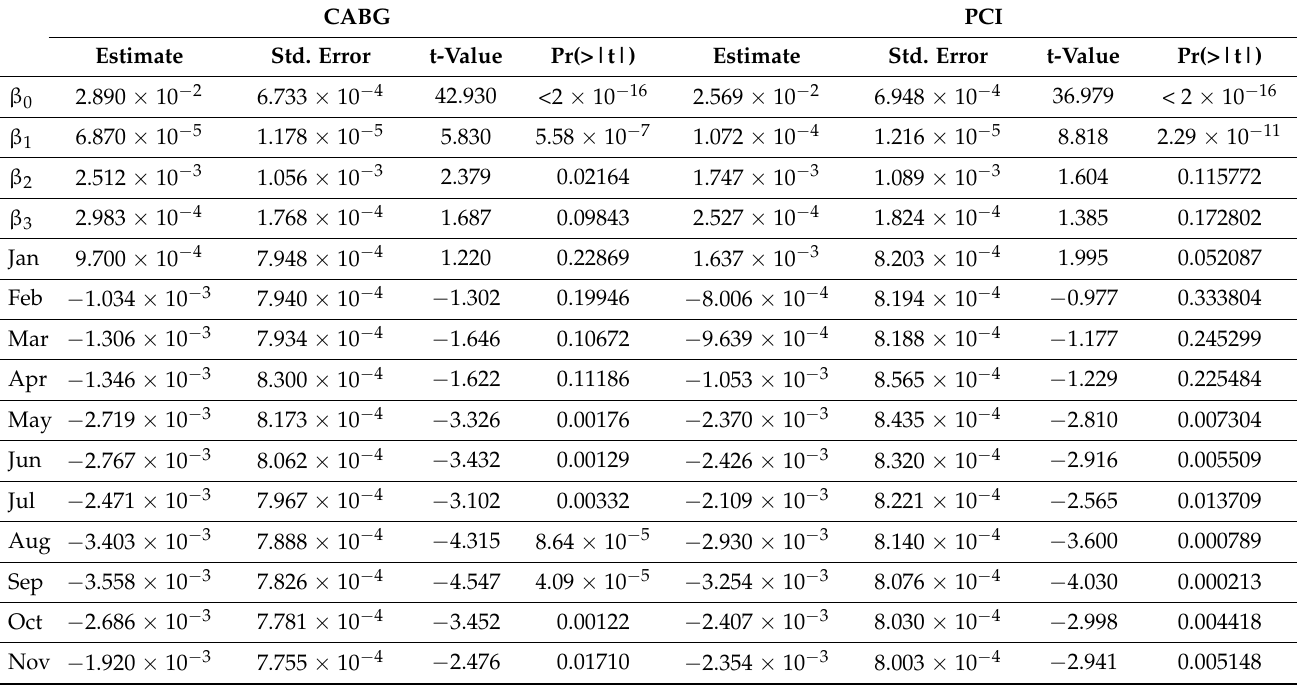
The joint hypothesis test robust to autocorrelation and heteroskedasticity rejected the null hypothesis for both CABG (4.204 × 10-07) and PCI (3.531 × 10-07) (Table 2). Thus,